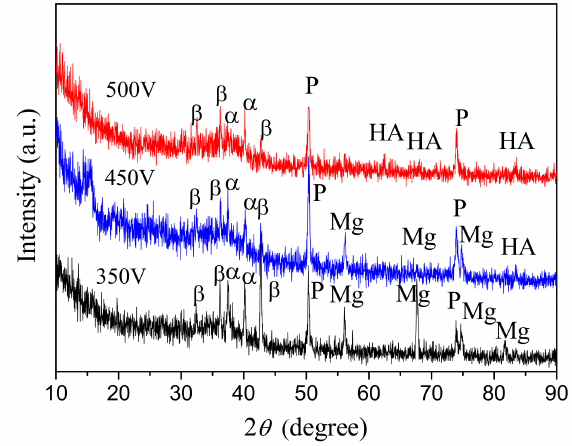
Figure 8. XRD patterns of the CaP coatings deposited on Mg-0.8Ca under different voltages for 5 min. β – β -Ca α – α -Ca 3 (PO 4 ) 2 , 3 (PO 4 ) 2 , HA–Ca 10 (PO 4 ) 6 (OH) 2 , P–MgO (periclase),